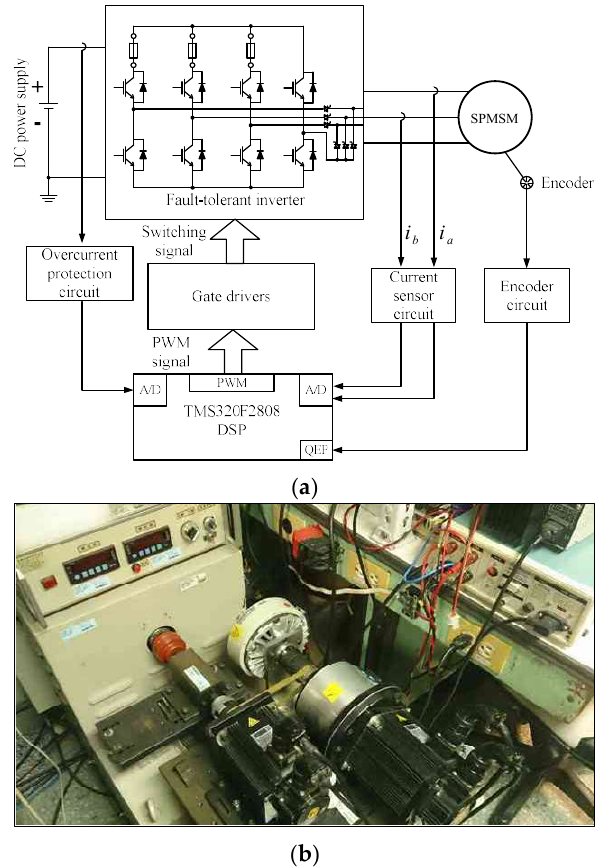
Figure 9. The implemented system ( a ) block diagram, and ( b ) photograph.